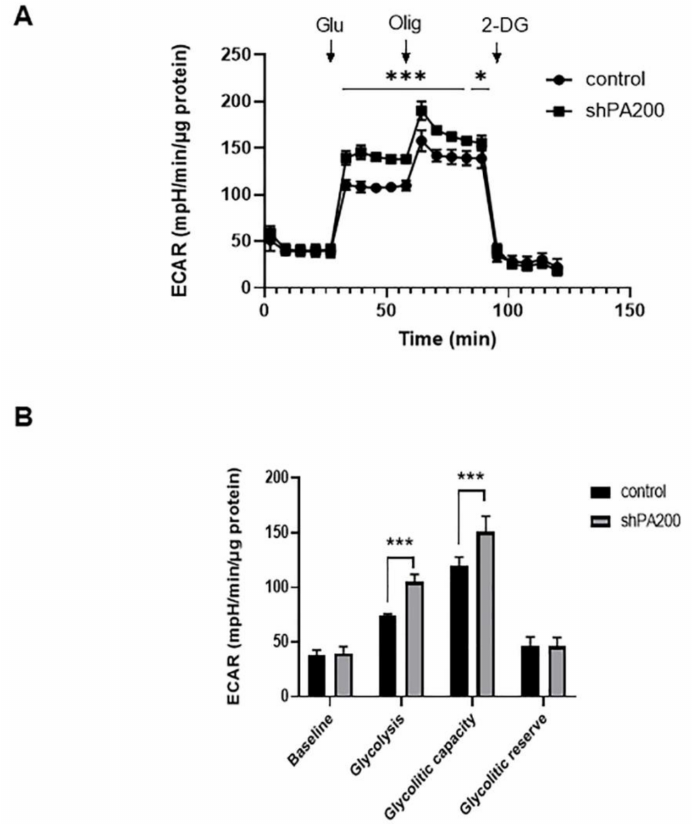
Figure 4. Increased glycolysis and glycolytic capacity in PA200 knockdown cells. ( A ) Glycolytic pro- file of PA200-depleted and control cells. Glycolysis was measured using the Seahorse XF 96 analyzer and was assessed by measuring the extracellular acidification rate (ECAR). The shPA200 and control cells were seeded in an XF-96 cell-culture microplate at 35,000 cells/well for 24 h. The following day, the media was replaced with glucose-free XF assay medium, and cells were incubated for 1 h without CO 2 . The basal ECAR was determined for 30 min prior to the injection of 10 mM glucose (Glu), 1 µ M oligomycin (Olig), and 50 mM 2-deoxy-d-glucose (2-DG). ( B ) Calculated values of glycolysis and glycolytic capacity of shPA200 and control cells normalized to total protein (mpH/min/ µ g protein). Data were analyzed using Wave Desktop software. Data are presented as mean values ± SD ( n = 4), and groups were compared using unpaired t -tests. (* indicates p < 0.05 and *** indicates p <